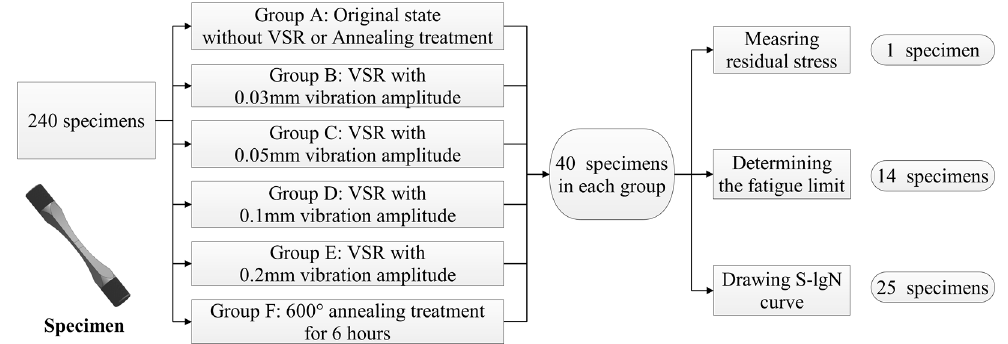
Figure 4. Grouping conditions of the vibratory stress relief(VSR) tests.